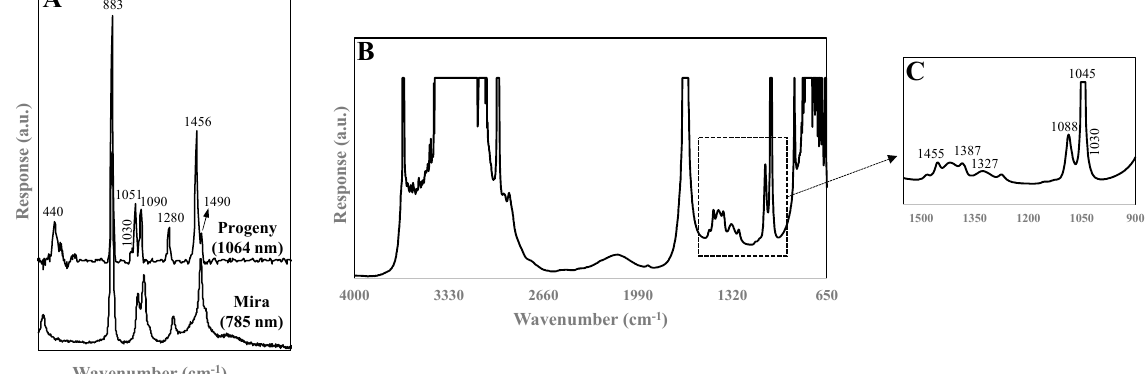
Figure 2. Typical Pisco spectra obtained from ( A ) handheld Progeny Rigaku (1064 nm) and Metrohm Mira M3 (785 nm) Raman instruments, ( B ) portable FT-IR device, and ( C ) fingerprint region of the Pisco spectrum given in ( B ).